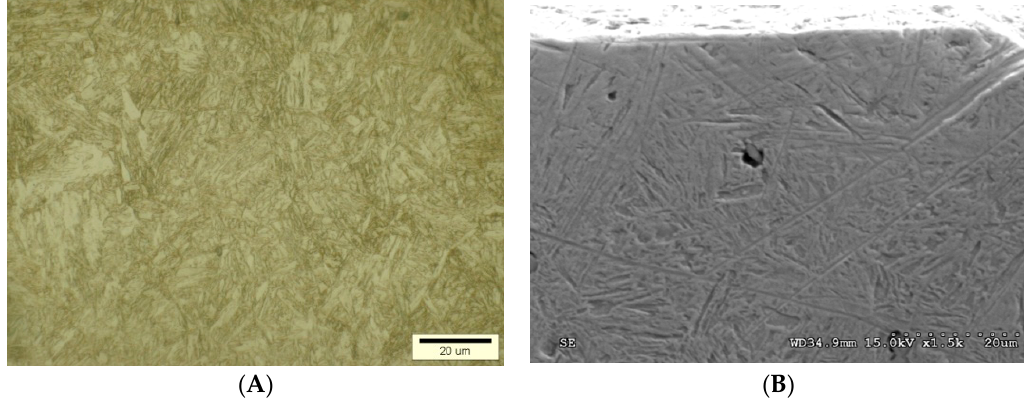
Figure 4. Microstructure of L20HGSNM steel cast ( A ) in the area approximately 0.5 mm under the surface (OM) and cross-section through the top layer of L35GSM ( B ) steel cast (OM).